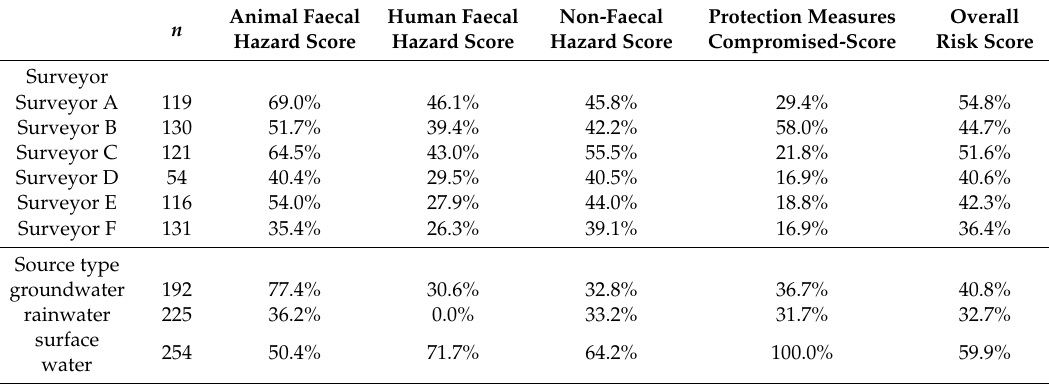
Table 1. Mean sanitary risk scores for each surveyor and by source type (Surveyor A: most experienced surveyor; Surveyor B: surveyor collecting water samples; Surveyor D: participated in wet season fieldwork only. Surveyor A’s visits were a median 0 days apart from those of his colleagues,